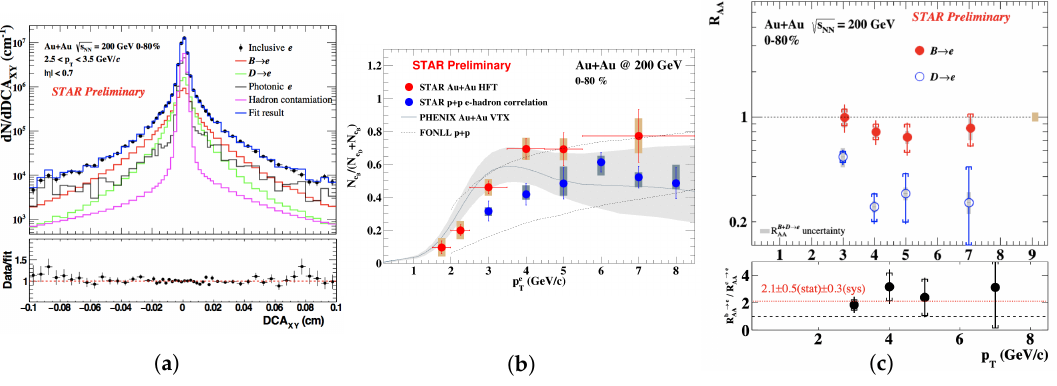
Figure 1. ( a ) Upper : DCA XY distribution for inclusive electrons with a template fit including B → e , D → e , and various background sources. Lower : Ratio of data to the fitted distribution. ( b ) fraction of B → e as a function of p T . ( c ) Upper : R B → e R D → e as a function of p T AA